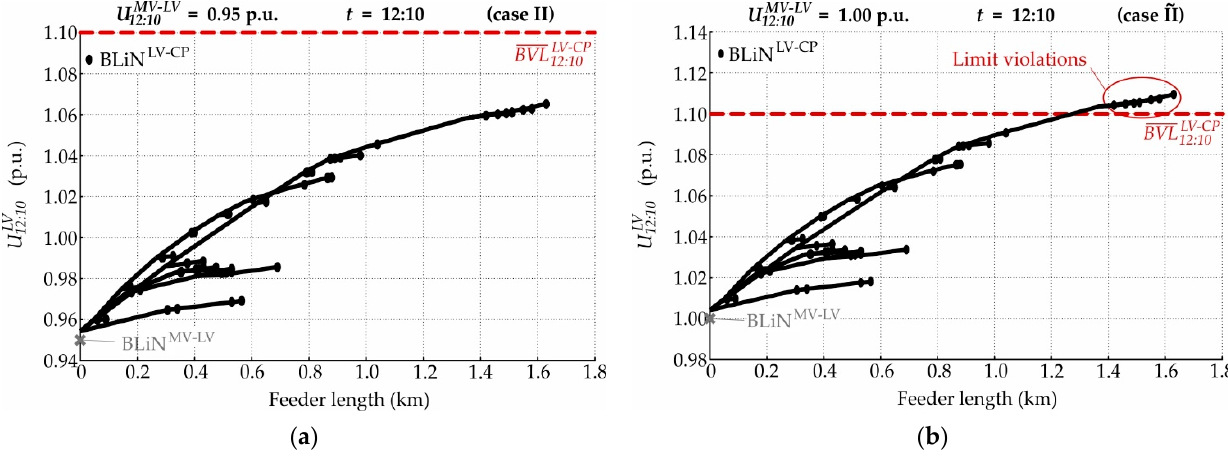
Figure 10. Voltage profiles of the rural LV_Link-Grid’s feeders without any Volt/var control at 12:10 p.m. for different MV − LV boundary voltages: ( a ) 0.95 p.u. (case II); ( b ) 1.00 p.u. (case II(cid:3561) ).